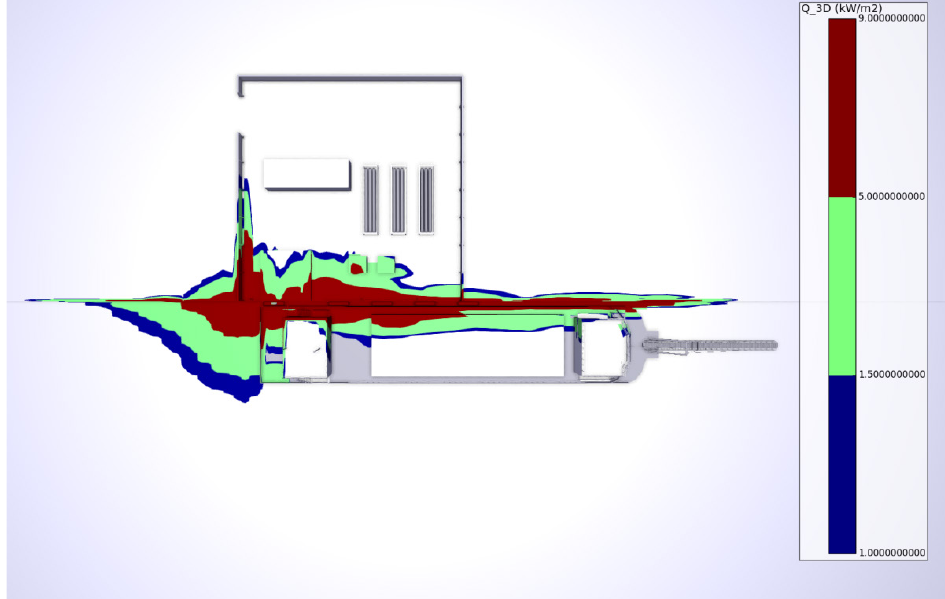
Figure 6. The distribution of fire thermal radiation in shore based bunkering operation for hydrogen powered ship.